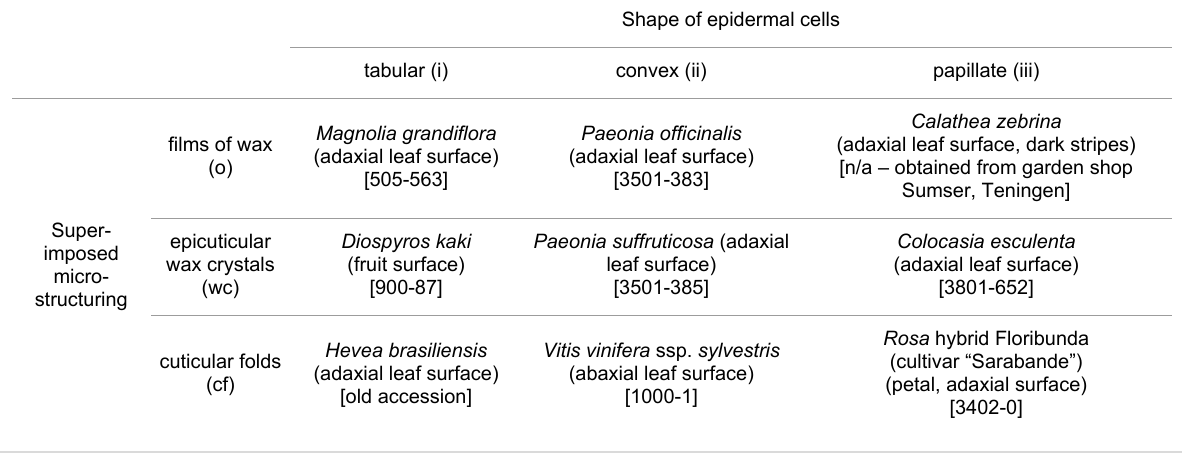
Table 2: Plant species selected. In square brackets: Accession number of the Botanical Garden of Freiburg.